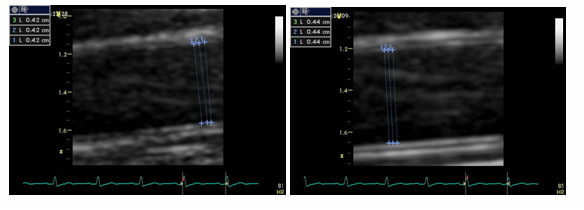
Two-dimensional images of the brachial artery in a case with impaired endothelium dependent flow mediated dilation. Brachial artery measurements were made from anterior intima to posterior intima at baseline, and during reactive hyperaemia. Endothelium dependent vasodilation response was 4.8%.